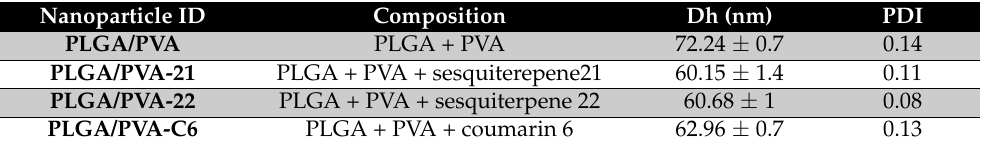
Table 1. PLGA/PVA nanoparticle formulations and particle characterization measured by dynamic light